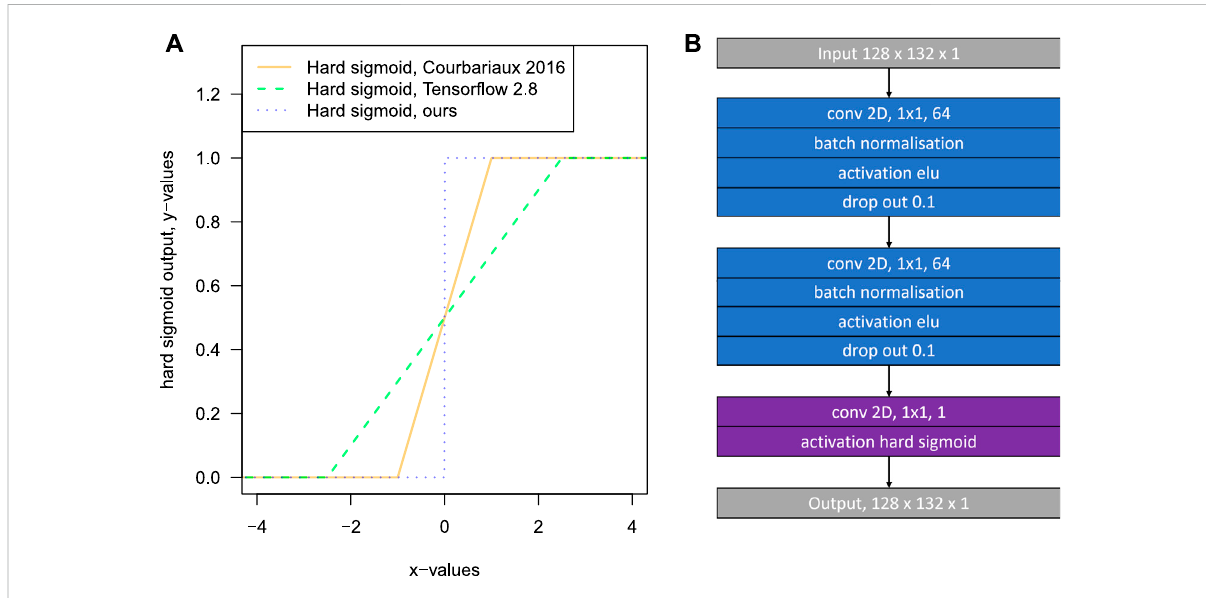
FIGURE 1 Hard sigmoid curves for x values ranging between − 4 and 4 for the function of Courbariaux et al. (2015), Tensor fl ow 2.8 (Abadi et al., 2016) and our function where the linear part rises from 0 to 1 for x values between 0 and 0.0002 in panel (A) . Panel (B) : Architecture of the hard sigmoid approximation σ CNN model. Note that all the convolution layers have kernels of 1 × 1 indicating that each value is independent of the